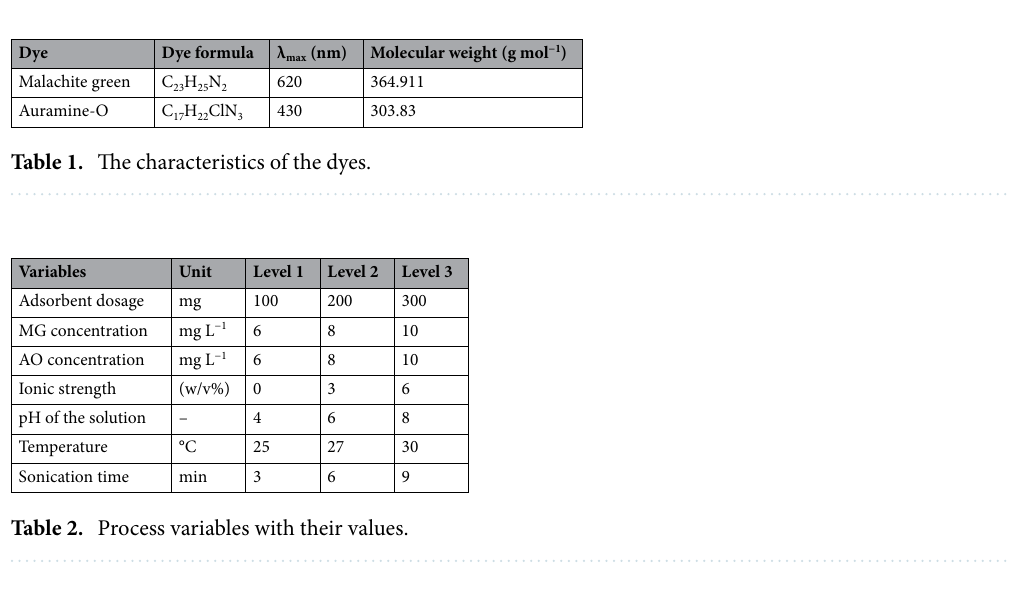
Figure 1. The chemical structure of (a) MG, and (b) AO.